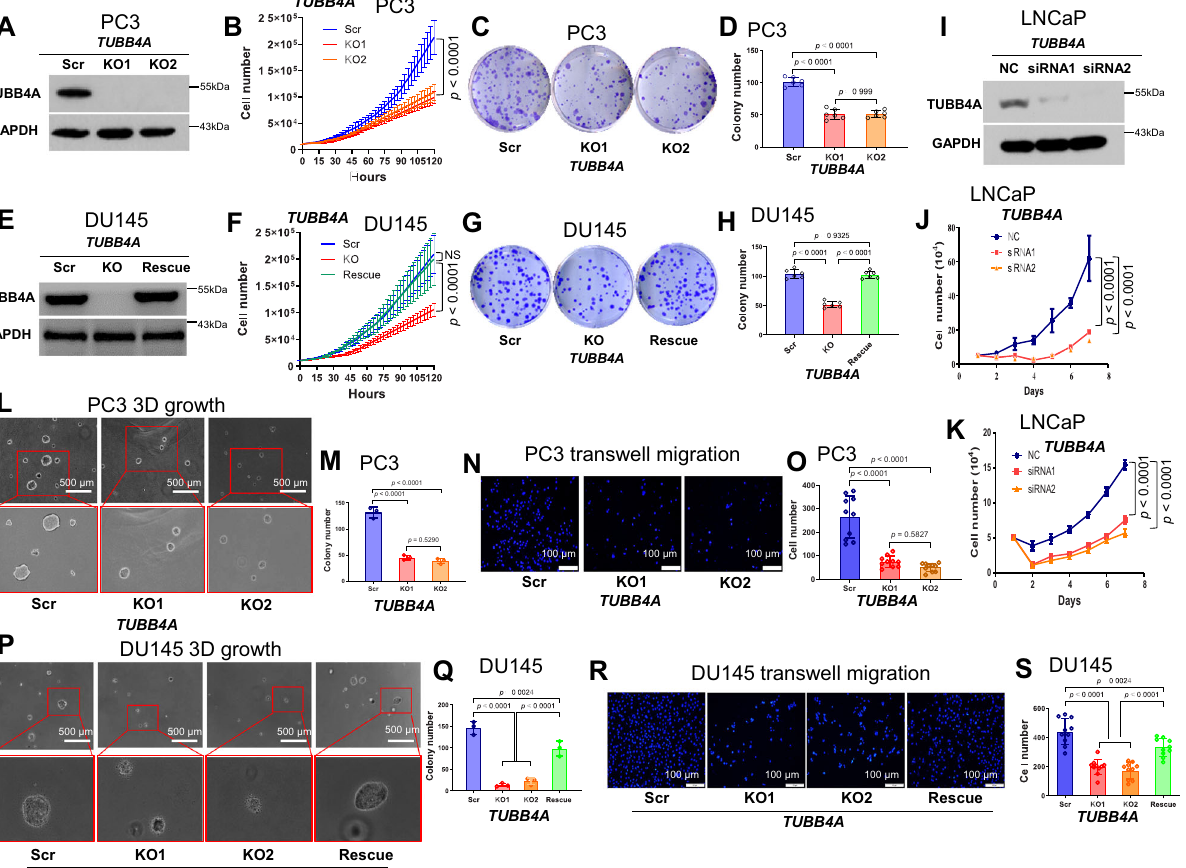
Fig. 2 TUBB4A KO reduces proliferation and migration of prostate cancer cells. A – D Con fi rmation of TUBB4A KO, cell growth, clone formation, and statistical analysis of PC3 cells. Cell growth was measured by live cell kinetic imaging with walk-away automation using a Lionheart ™ FX cell imager. A colony was considered to be 50 cells or more as determined microscopically. E con fi rmation of TUBB4A KO and rescue of DU145 cells. F – H Cell growth, clone formation, and statistical analysis of DU145 cells. I , J Con fi rmation of TUBB4A knockdown (KD) and cell growth of LNCaP cells. K Cell growth assay of LNCaP cells transfected with TUBB4A siRNAs in androgen-depleted culture medium. L , M 3D soft-agar colony formation and statistical analysis of PC3 cells. A 3D colony was counted based on the capacity of single cells to grow to colonies consisting of at least 50 cells. Scale bar, 500 μ m. N , O Transwell assay and statistical analysis of PC3 cells. Scale bar, 100 μ m. P , Q 3D soft-agar colony formation and statistical analysis of DU145 cells. Scale bar, 500 μ m. R , S Transwell assay and statistical analysis of DU145 cells. Scale bar, 100 μ m. Data are replicated 3 ( J , K , M , Q ), 4 ( B , F ), 6 ( D , H ), and 10 ( O , S ) times. Data are presented as the means and SD with a repeated measures ANOVA ( B , F , J , K ) or an ANOVA followed by Tukey ’ s post hoc t test ( D , H , M , O , Q , S ). Source data are provided as a Source data fi le. Scr, scramble; KO, knockout; NC, negative control siRNA; siRNA, small interfering RNA; NS, no signi fi cant